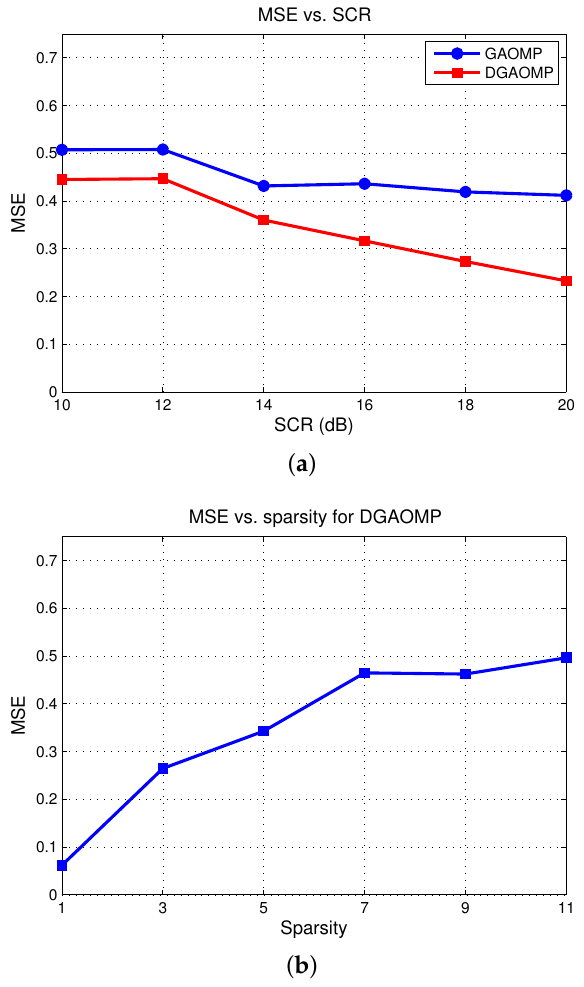
Figure 9. ( a ) MSE versus Signal-to-Clutter Ratio (SCR) for GAOMP and DGAOMP. The error is more for GAOMP; ( b ) MSE versus sparsity for DGAOMP. Increasing sparsity leads to a higher